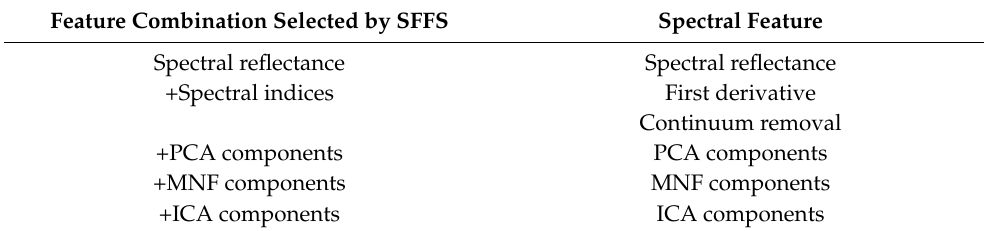
Table 3. Scenarios used for classification based on hyperspectral data.